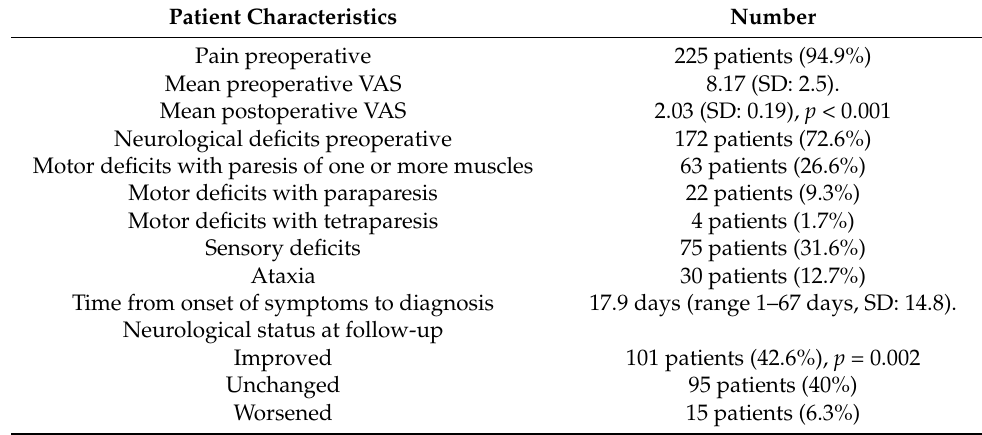
Table 2. Symptoms and neurological